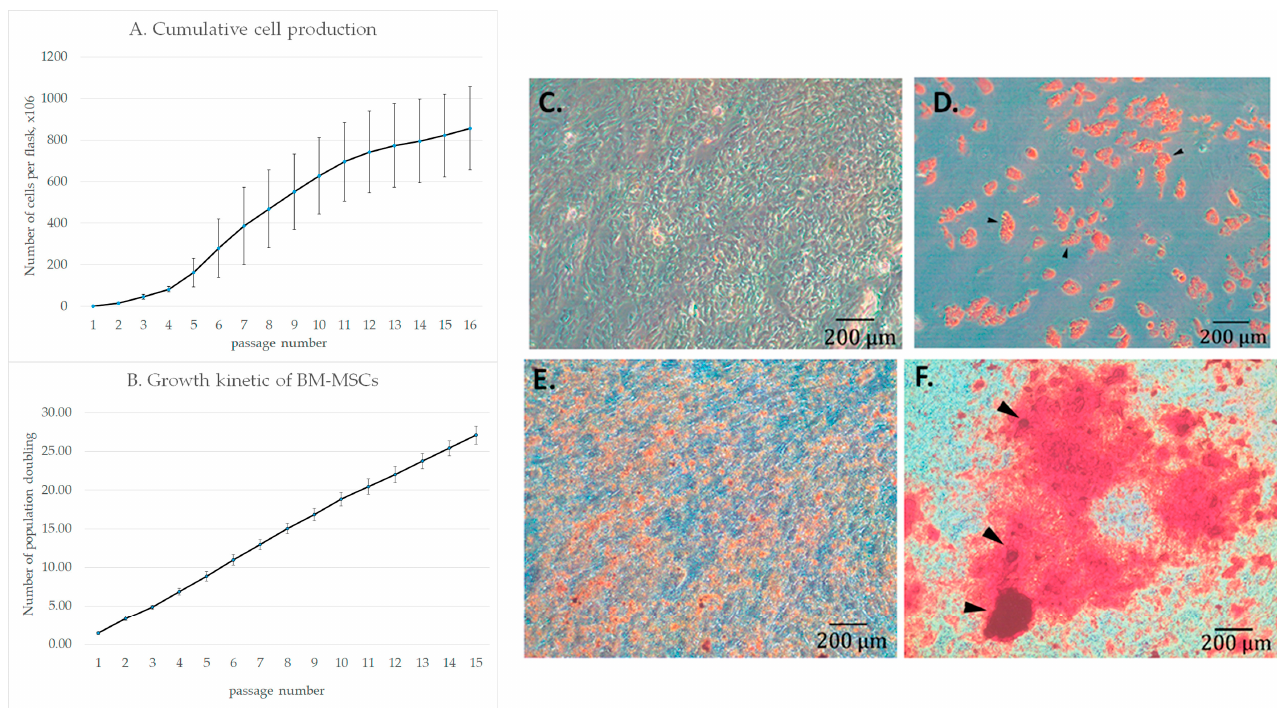
Figure 1. Proliferative and differentiating potential of porcine BM-derived MSCs (BM-MSCs). ( A ) Cumulative cell production. ( B ) MSC Growth Kinetics for 15 Passages. Mean values from four independent samples of BM-MSCs obtained from different animals are presented. ( C ) Control cells stained with Oil Red O. Photo of Pig#106 cells. ( D ) Induction of adipogenic differentiation stained with Oil Red O. Photo of Pig#106 cells. Black arrows point to fat droplets. Magnification 10×. ( E ) Control cells stained with Alizarin Red. Photo of Pig#106 cells. ( F ) Induction of osteogenic differentiation stained with Alizarin red. Photo of Pig#106 cells. Black arrows show calcium deposits. Magnification 10 ×